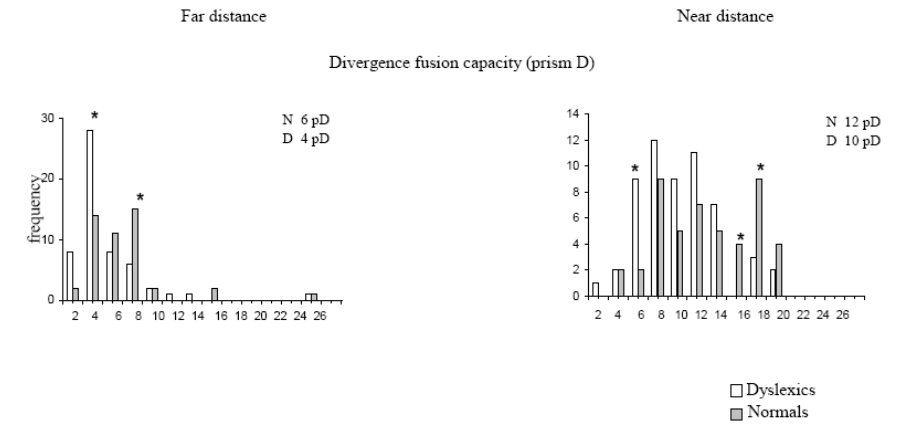
Figure 4. Divergence fusion capacity distribution for dyslexic (white bars) and normal (grey bars) children at far and near dis- tance. The median of dyslexics and normals is also given. Asterisks indicate a significant difference between dyslexics and